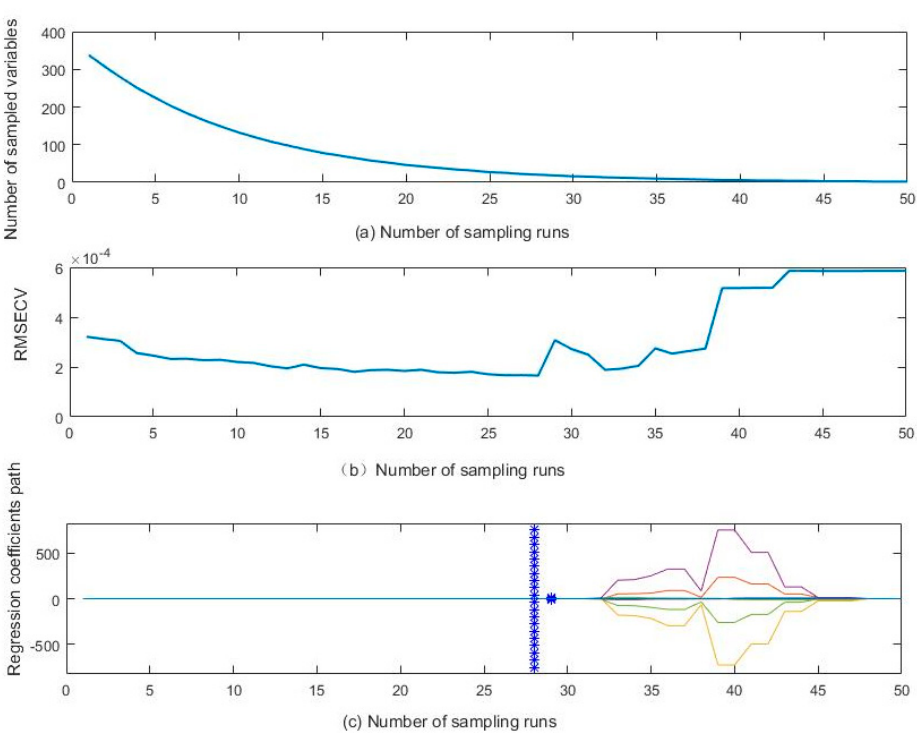
Figure 8. Variable selection results of full THz spectrum of benzoic acid aqueous solution samples using CARS algorithm. ( a ) is the selection results of the mixed sample of wheat flour and BA by CARS algorithm; ( b ) shows the trend plot of RMSECV values corresponding to increasing number of sampling runs; ( c ) shows a trend diagram in which the regression coefficient of the wavelength variable changes with the increasing of sampling runs in the wavelength selection process. Table 2. Modeling effects of the PLS models by using various methods for selecting wavelength variables.